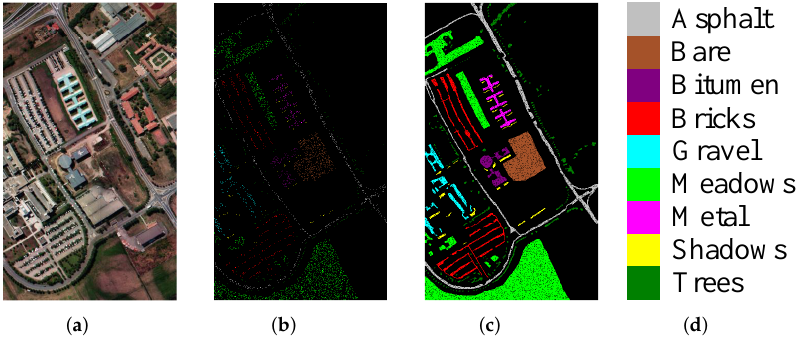
Figure 4. UP dataset. ( a ) Composite image. ( b ) Training set. ( c ) Test set. ( d ) Legend. Table 2. The number of training sets and test samples covered by each surface selected on the UP dataset, and the number of all in each